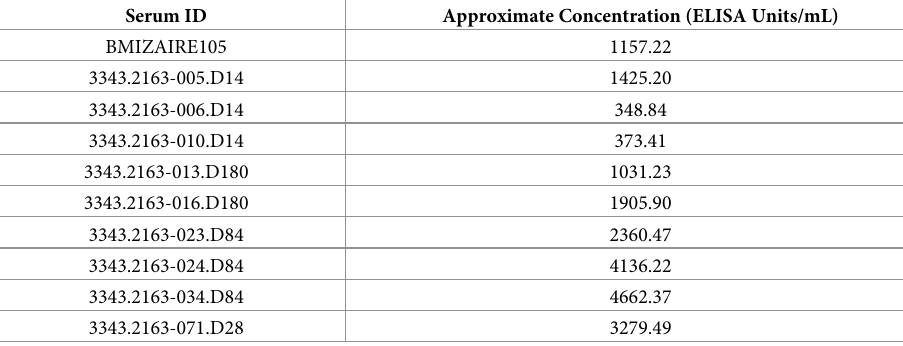
Table 6. Immune human serum samples used to generate